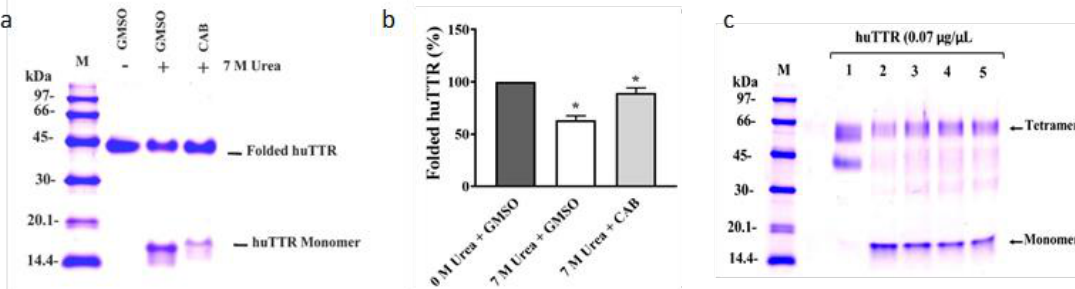
Figure 2. ( a ) Resistance to urea-mediated denaturation of huTTR in the presence and absence of Centella asiatica bioactive (CAB) components. HuTTR (0.07 µg/µL) was incubated in the presence of CAB (6.67 µg/µL) dissolve in GMSO or in the presence of GMSO only. ( b ) Bar chart represents the means of huTTR with and without CAB (protein: CAB mass ratio 1:100) and with their standard errors. * values are significantly different at p < 0.05. ( c ) Tricine SDS-PAGE gel (10%) of huTTR with increasing concentrations of CAB subjected to urea-denaturation stress and cross-linked with glutaraldehyde. M: Protein molecular weight marker; 1: 0 M urea + GMSO only; 2: 7 M urea + GMSO only; 3: 7 M urea + CAB (3.33 µg/µL); 4: 7 M urea + CAB (6.66 µg/µL); 5: 7 M urea + CAB (13.33 µg/µL).